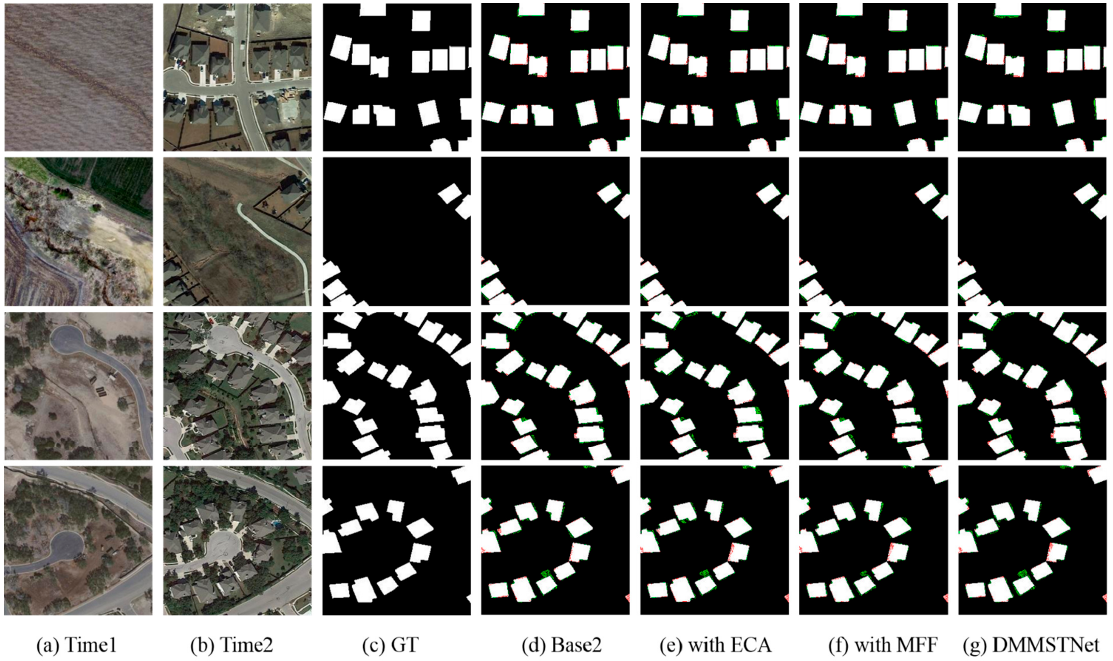
Figure 12. Ablation Base2 experimental results on the LEVIR-CD dataset. ( a ) The images at time1. ( b ) The images at time2. ( c ) The ground truth. ( d ) The results of Base2. ( e ) The results of “Base2 + ECA”. ( f ) The results of “Base2 + MFF”. ( g ) The results of DMMSTNet.